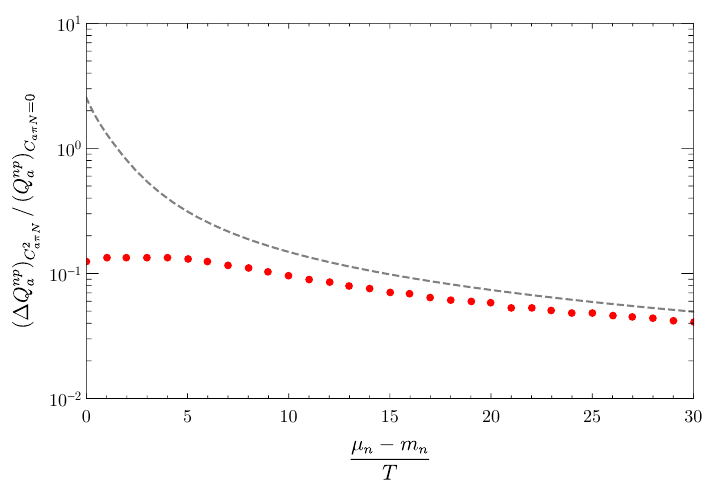
Figure 6 . The ratio of the axion emissivity contributed from the contact interaction, i.e. C aπN coupling, to that from the other couplings, C ap and C an . We compare the numerical result (red dots) with an analytic estimation (dashed). For benchmark parameters, we assume µ p − m p ’ 0 . 25( µ n − m n ) and C ap = − C an = 1 / 2